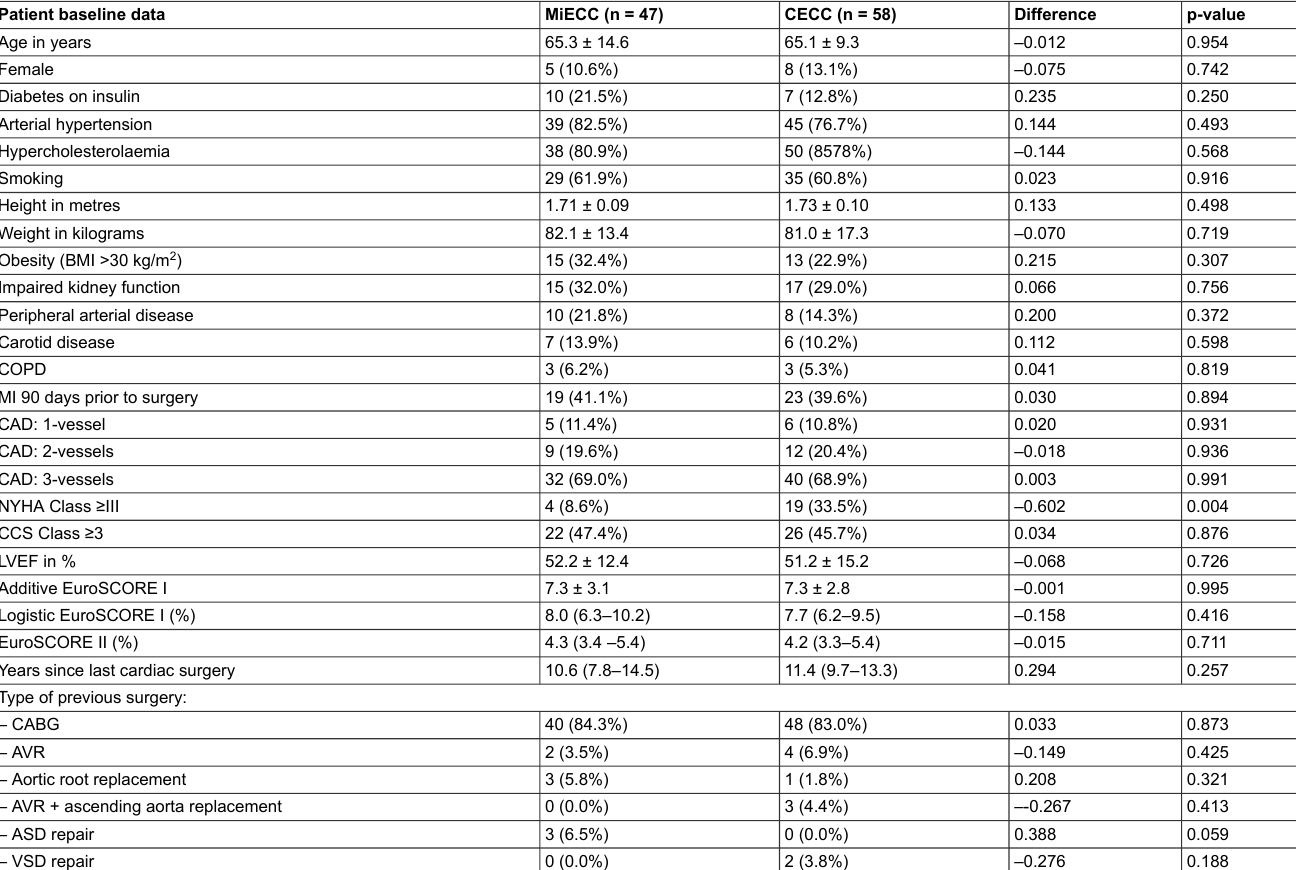
Table 1: Preoperative patient baseline data after propensity score matching and after inverse probability of treatment weighting (IPTW).